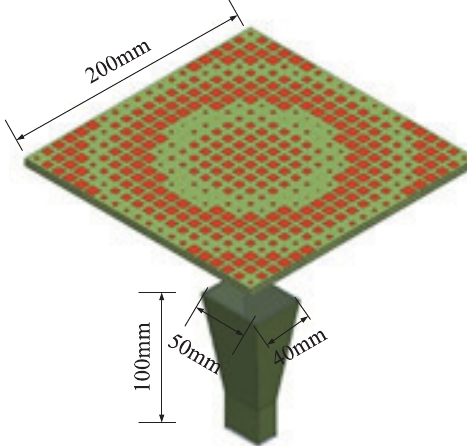
Fig. 6. Overall model of the high-gain antenna